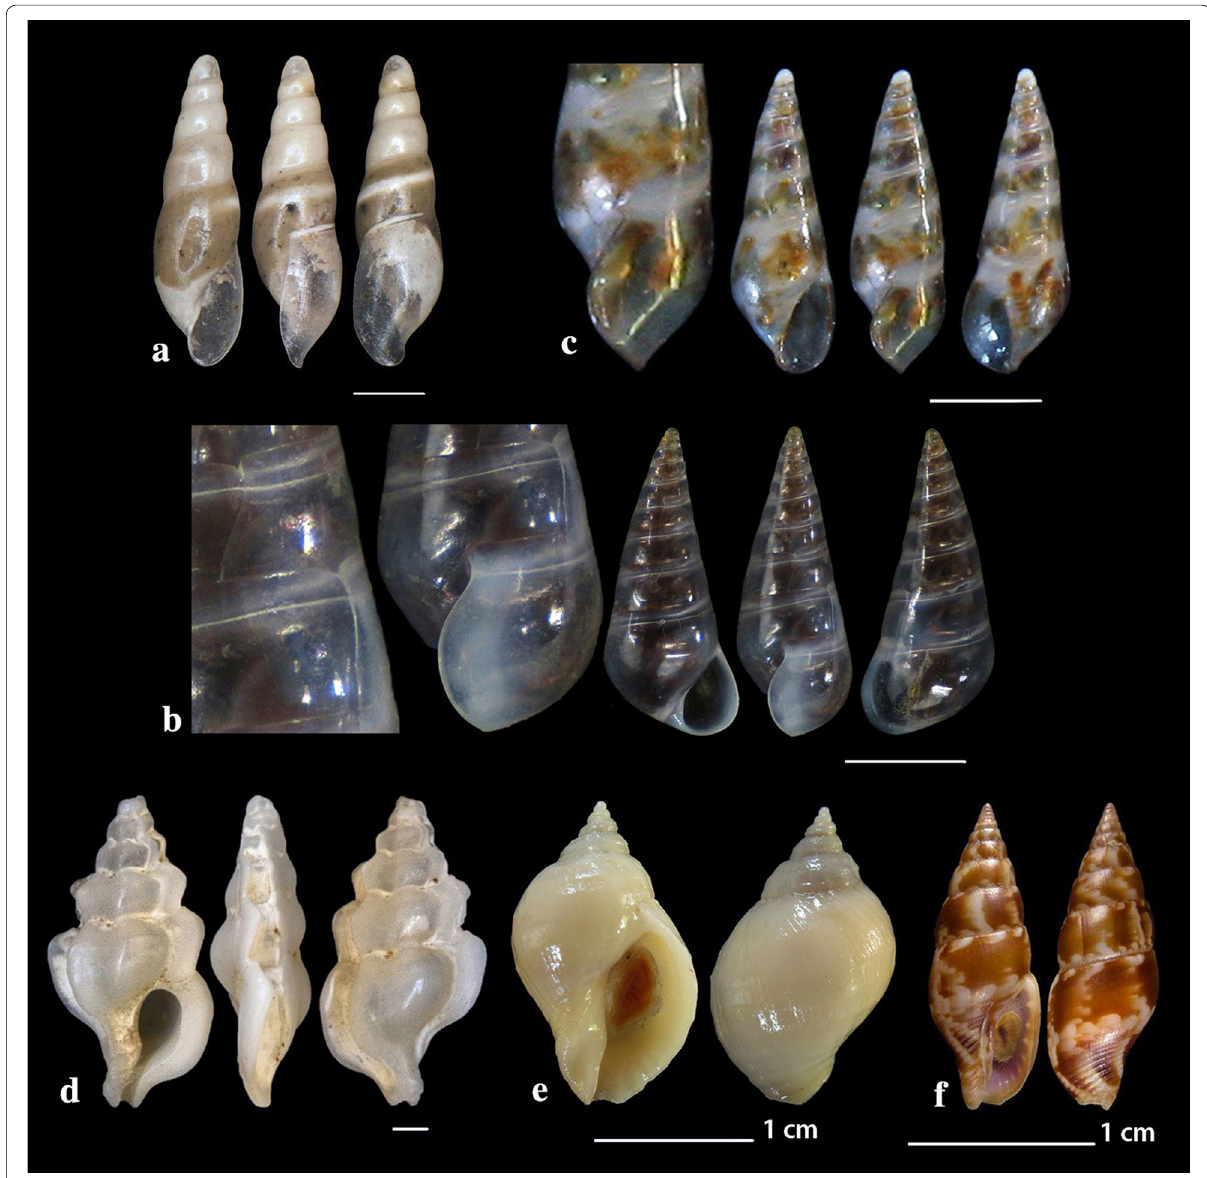
Fig. 20 a Haliella stenostoma , b Nanobalcis nana , c Sticteulima jeffreysiana , d Aspella anceps , e Nucella lapillus , f Mitrella pallaryi . Bar otherwise